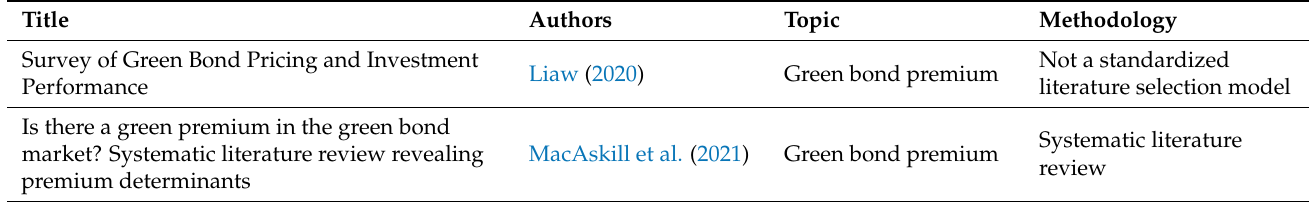
Table 3. Main characteristics of previously green bond literature